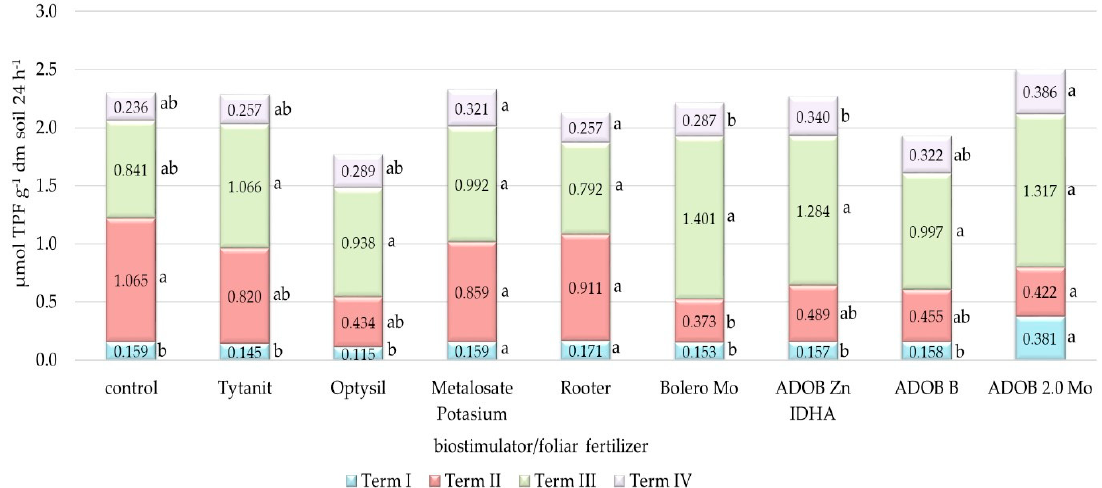
Figure 4. The influence of the bio-stimulants and fertilizers on the dehydrogenase activity. Abbreviation: a, b—homogenous groups according to Duncan’s test at level p = 0.05; I term—at the plants’ emergence